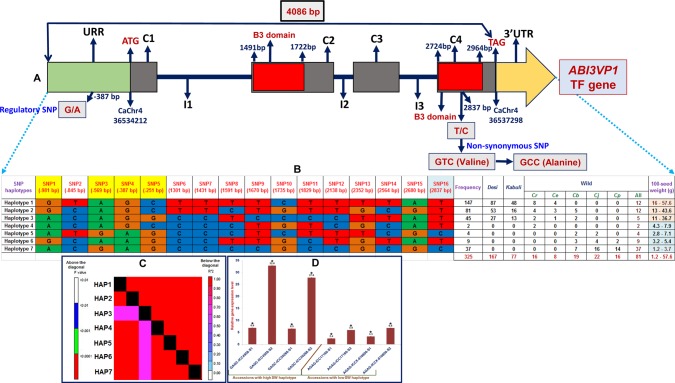
The molecular haplotyping, LD mapping and gene haplotype-specific association analysis in an ABI3VP1 TF gene validating its strong association potential for SW in chickpea. The genotyping of 16 SNPs including one non-synonymous SNP (T/C) [encoding valine (GTC) to alanine (GCC)] in the B3 functional domain and five regulatory SNPs in the URR of this gene (A) among 244 cultivated and 81 wild chickpea accessions constituted seven haplotypes (B). Thirty-seven low seed weight (1.2–3.7 g) accessions represented by single haplotype group 7 (AGAG) and two other haplotypes (GAGC) consisting 24 accessions of high seed weight (13–57.6 g) in the TF gene showed strong association potential for high and low SW differentiation. The seven SNP haplotype-based genotyping information produced higher LD estimates (r2 > 0.60 and P < 0.0001) covering the entire 4,086 bp sequenced region of gene (C). The high (GAGC) and low (AGAG) seed weight-specific haplotypes constituted by four SNPs (shaded with yellow colour in B) in URR of TF gene are depicted (B). (D) The differential expression profiling of ABI3VP1 TF gene in high and low seed weight accessions during seed development compared with the leaf. A superior favourable high seed weight-regulating haplotype (GAGC) with increased transcript expression was identified in the URR of TF gene (D). Each bars represent the mean (±standard error) of three independent biological replicates with two technical replicates for each sample used in quantitative RT–PCR assay. *Significant differences in expression of gene haplotypes at two seed developmental stages of low and high seed weight accessions compared with leaf (LSD-ANOVA significance test at P < 0.01). This figure appears in colour in the online version of DNA Research.